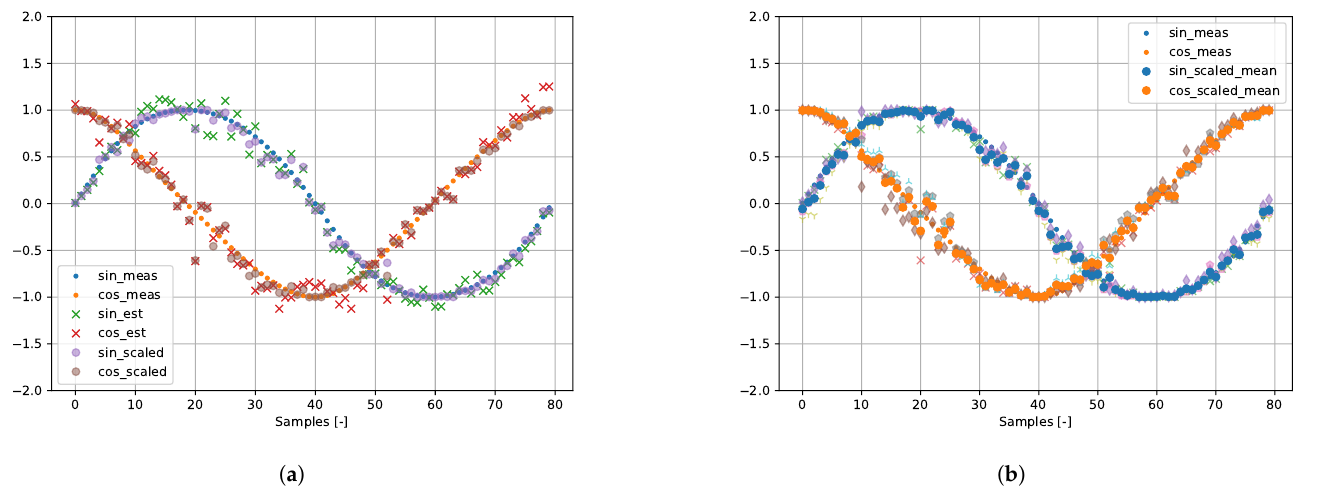
Figure 9. Single shaft rotation (electric angle), sine, and cosine of shaft position. ( a ) Using a single ANN. ( b ) Using multiple ANNs. Visible (not labeled) scaled responses of all used ANNs.